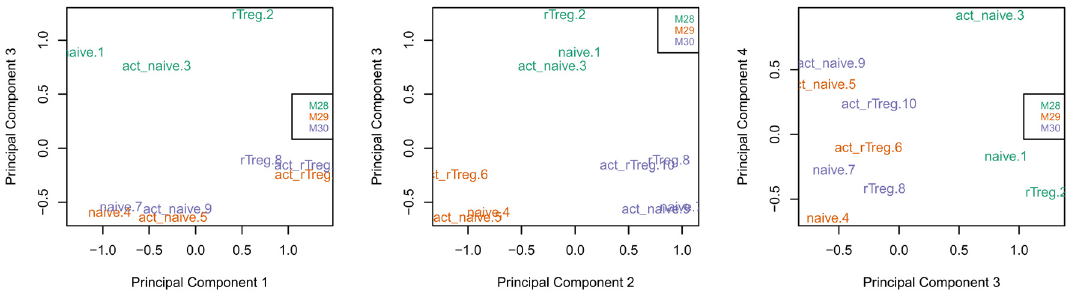
Figure 7. Examining the higher dimensions of the MDS plots shows that significant inter-individual variation still exists in the second and third principal components.